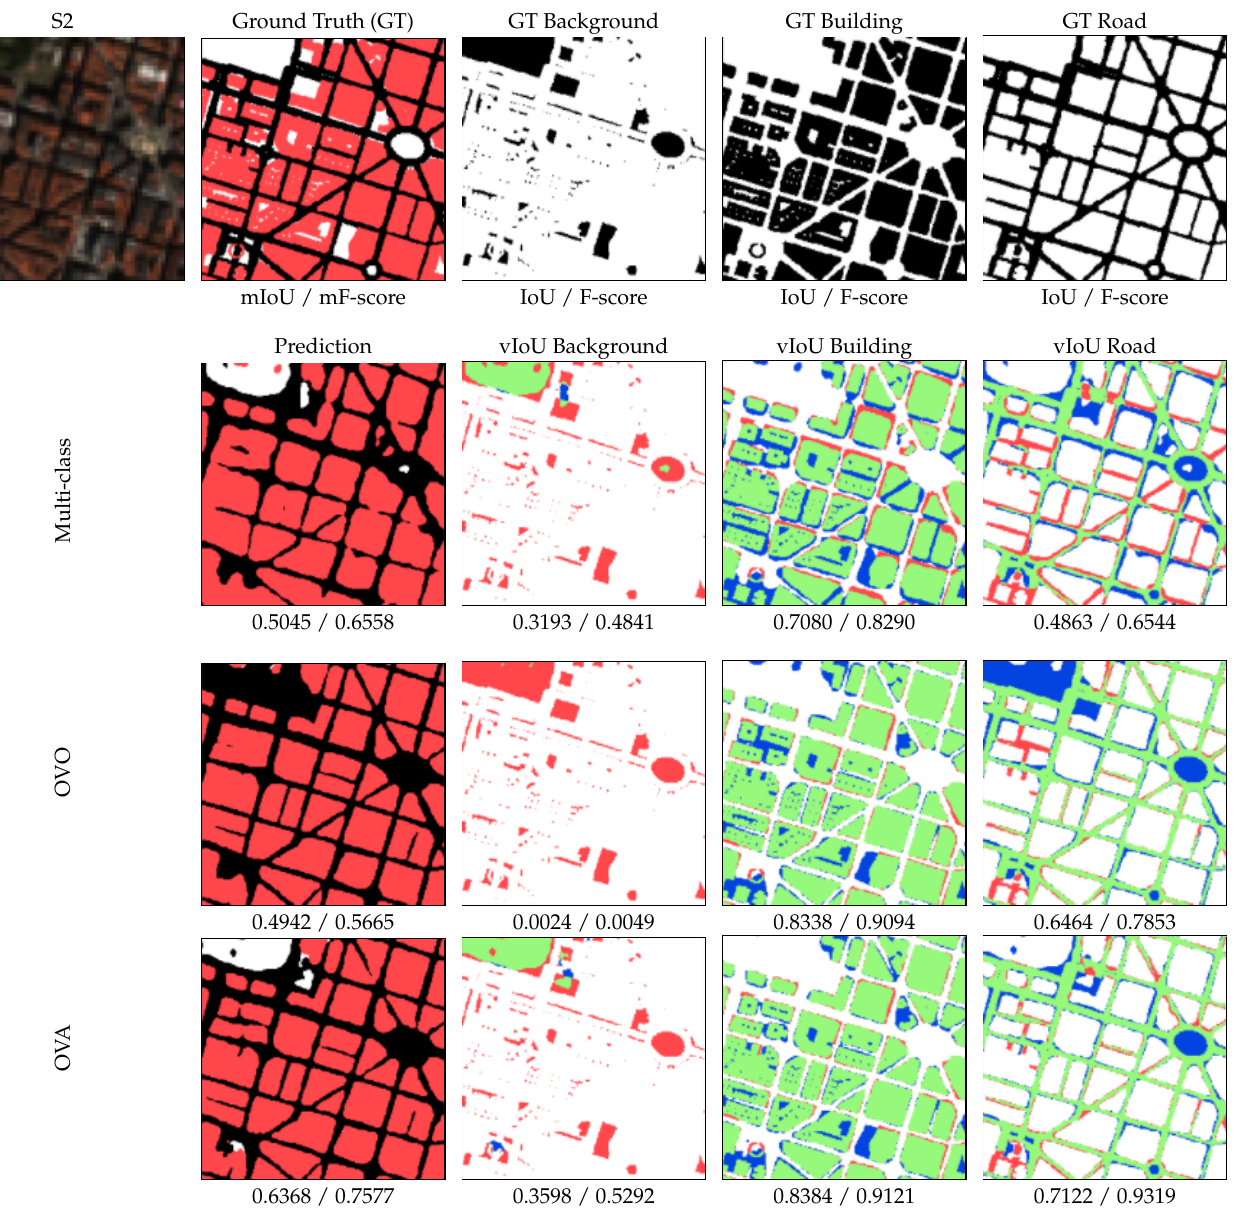
Figure 8. Qualitative results for the benefits of using decomposition strategies. Visual comparison of the results obtained with the direct multi-class approach vs. OVA and OVO binary decomposition strategies for a zone taken from Barcelona North city in the test set. TP are presented in green, FP in blue, FN in red and TN in